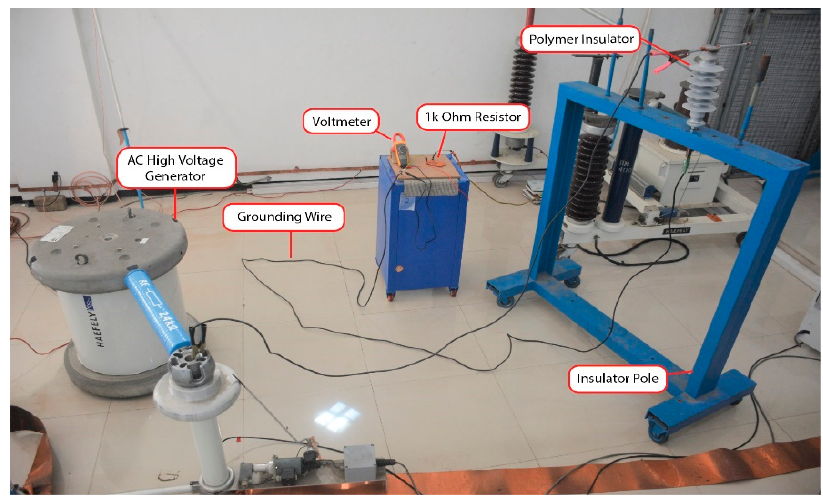
Figure 6. Insulator test circuit.